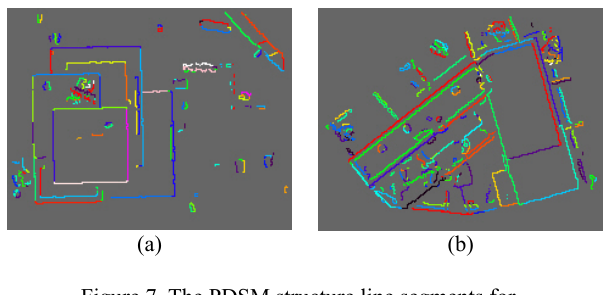
Figure 7. The PDSM structure line segments for